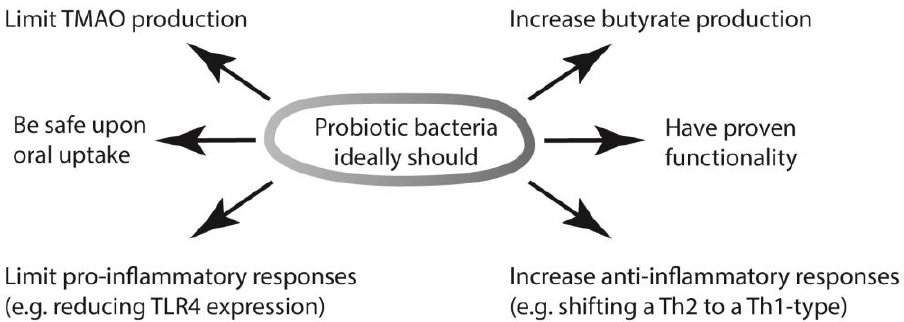
Figure 3. The required activities of ideal probiotic bacteria can now be proposed based on mechanistic understandings so that they can benefit the health of organs beyond the gut.